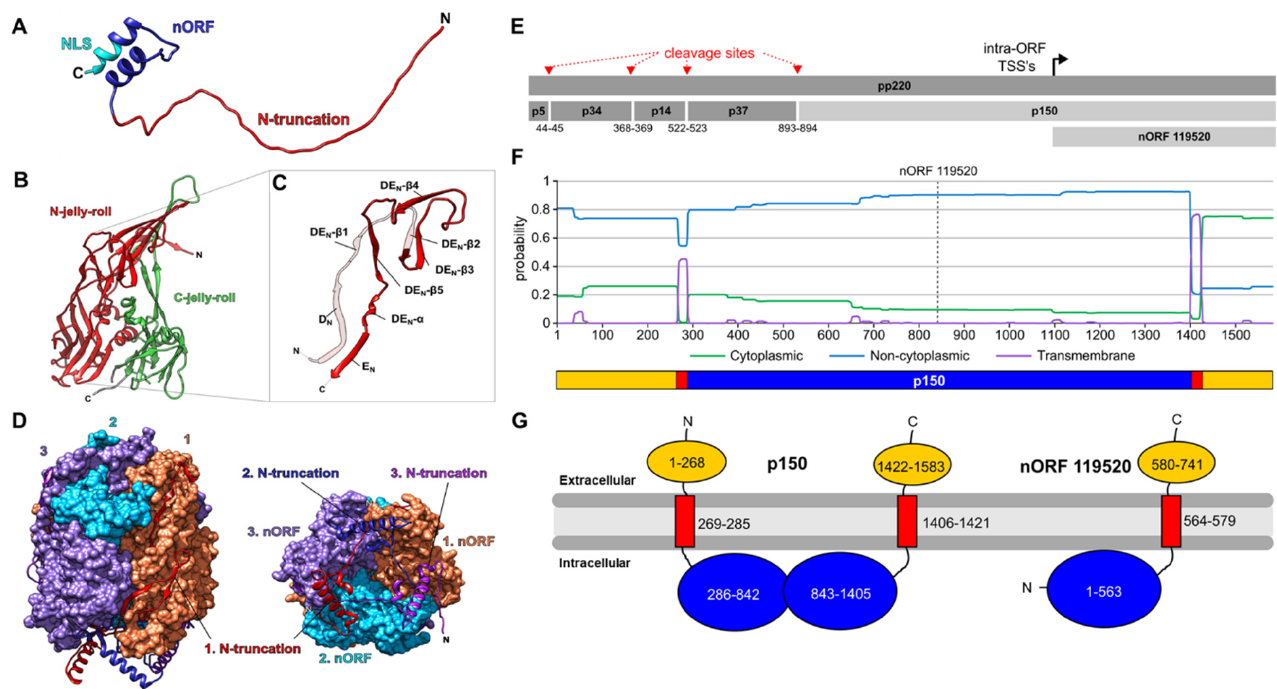
Figure 3. ( A ) AlphaFold structure predictions of full-length p10 (K78R). The 37-residue region lacking in the N-truncated variant is shown in red, and the 41-aa potential nORF_63974 protein is in blue. The C-terminal sequence KKIKRSK in cyan is predicted to contain a nuclear localization signal (NLS). ( B – D ) The structure of p72 PDB: 6KU9, and the structure prediction of nORF_105178. ( B ) The structure of a p72 monomer with the N and C-terminal jelly-roll domains, coloured and labelled in red and green, respectively. ( C ) The structure of the p72 DE N -loop, with secondary structure features annotated. The region missing in the N-truncated variant nORF_105178 (transparent) consists of D N , DE N - β 1, and DE N - β 2. ( D ) Side (left) and bottom (rotated by 270°, right) view of the p72-homotrimer, with surface representations of monomers 1, 2, and 3 in salmon, cyan, and lilac, respectively. The residues missing in nORF_105178 are shown as a ribbon. ( E – G ) The N-truncation of p150 and its potential effect on protein function. ( E ) Schematic representation of pp220 processing by protease pS273R into proteins p5, p34, p14, p37, and p150 (red arrows). The black arrow represents the intra-ORF TSS within the p150 sequence giving rise to nORF_119520. ( F ) Probability plot predicting transmembrane (TM) and cytoplasmic domains of p150 using the Phobius web server [63]. ( G ) Schematic representation of full-length p150 and nORF_119520 domains predicted by PSIPRED and TMHMM in relation to a membrane (grey). The numbered residues are coloured according to the predicted location by the PSIPRED: MEMSAT-SVM algorithm; extracellular location is yellow, the transmembrane helices are red, and intracellular location is blue.